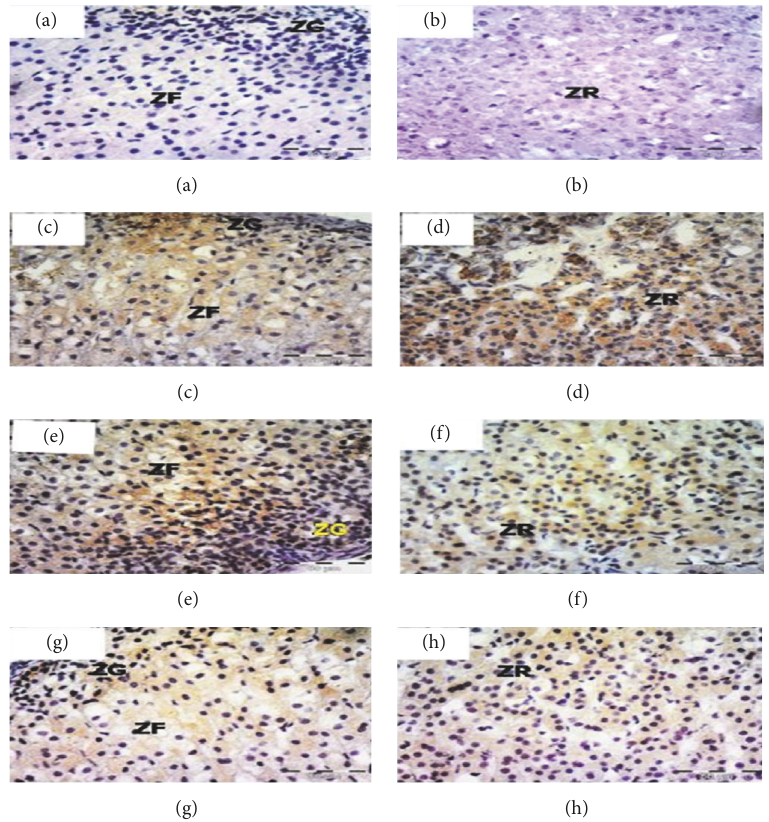
Figure 5: Rat adrenal cortex labeled for iNOS of the control group (a and b) showing negative expression; Group II (c and d) showing high expression along the adrenal cortex; Group III showing high expression in ZG and ZR (e) and moderate expression in ZR (f); Group IV (g and h) showing faint expressions through the adrenal cortex, × 400. Zona glomerulosa (ZG), zona fasciculata (ZF), and zona reticularis